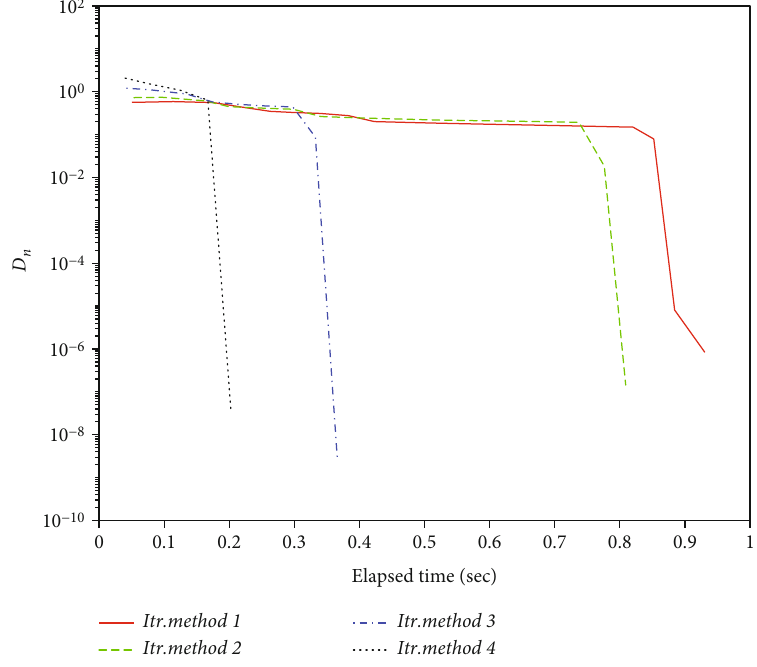
Figure 10: All methods are compared computationally while x